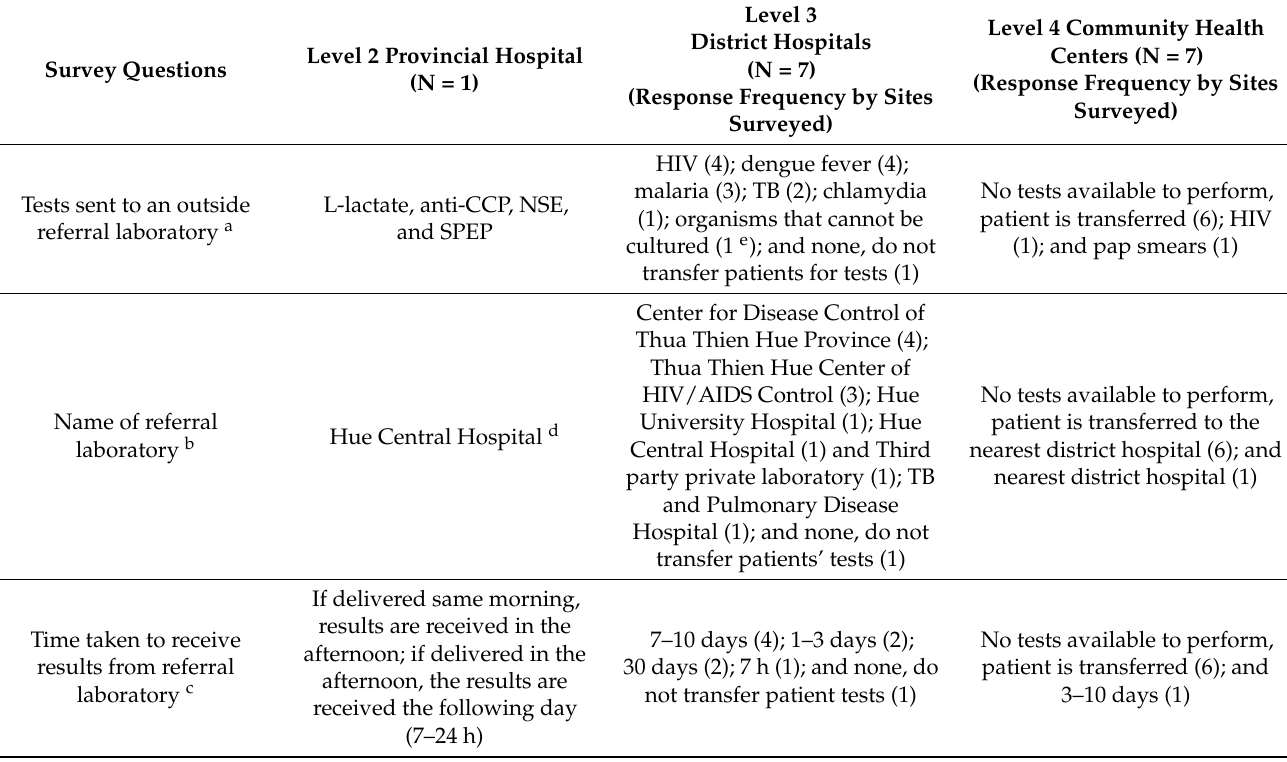
Table 5. Therapeutic turnaround time for tests sent to referral laboratories.